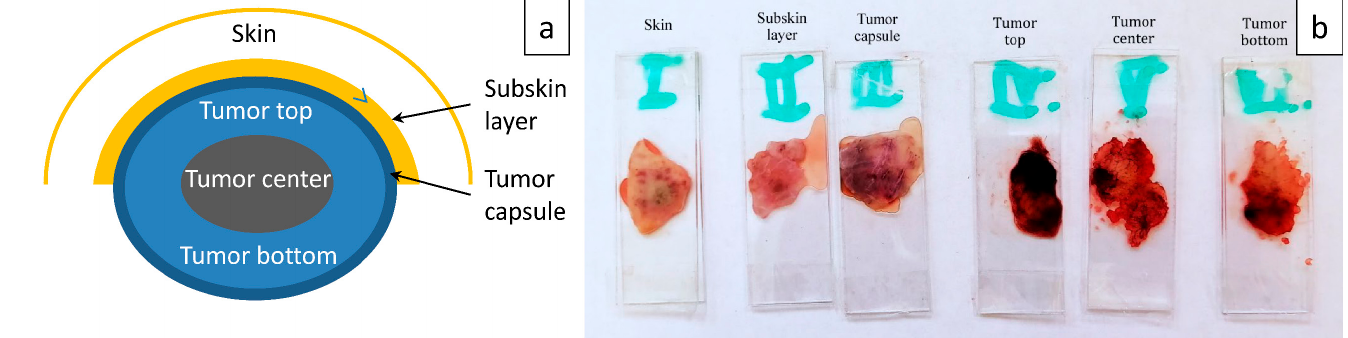
Figure 4. The scheme of the model tumor ( a ) and the samples of the tissue layers ( b ).